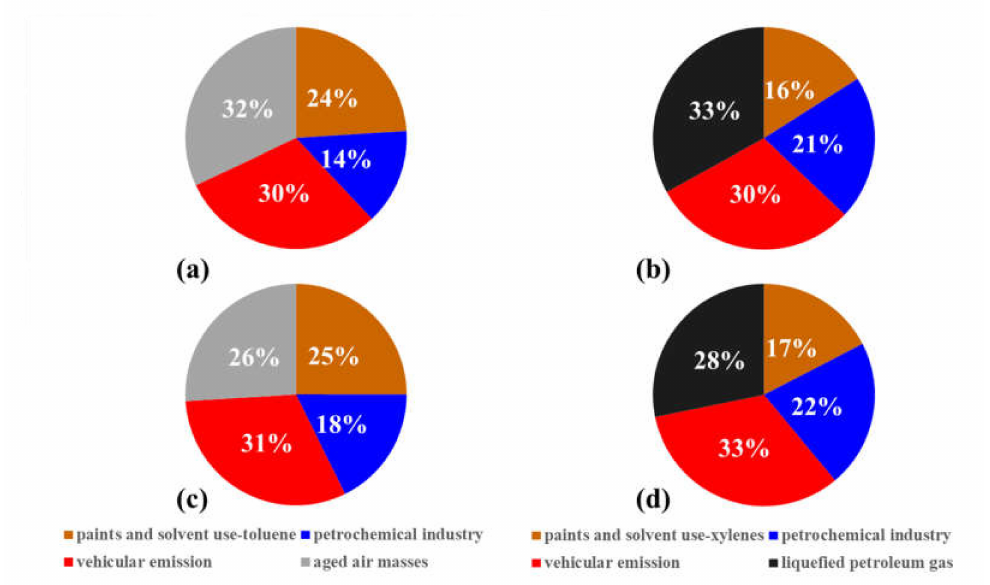
Figure 10. Relative contributions of di ff erent sources to NMHCs mixing ratios from ( a,b ) 1–31 July and ( c,d ) O 3 pollution episodes ( a,c ) at the DSH site and ( b,d ) the PD